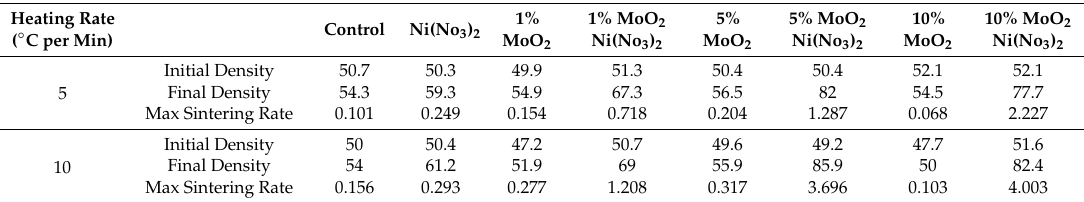
Table 1. Green density, final sintered density, and maximum sintering rate; density measurements are relative to 5.9 g / cm 3 and given as a percent of theoretical density, and sintering rate as change in percent relative density per minute (% / min) (Adapted from